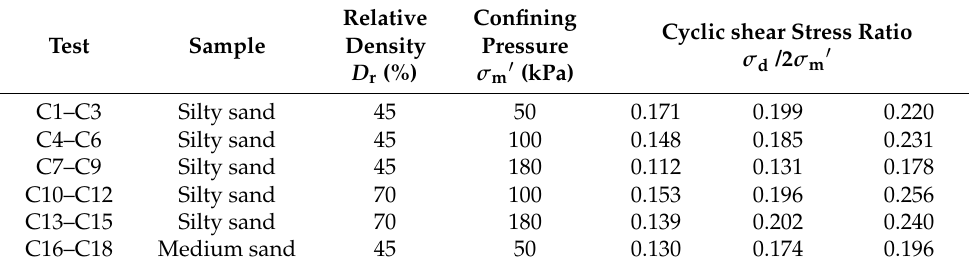
Table 3. Cyclic triaxial test scheme of remolded soil in the East Nan-ao area.